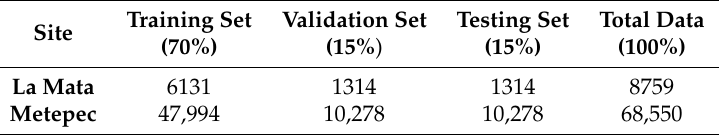
Table 4. Datasets for the forecasting